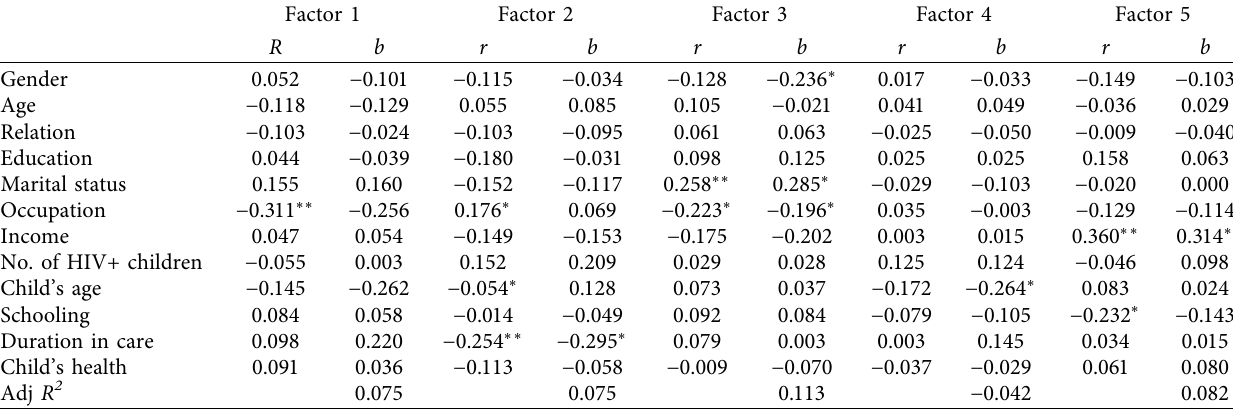
Table 6: Correlation coefficients and standardized beta weights between the five coping subscales and caregiver and child sociodemographic characteristics ( n �